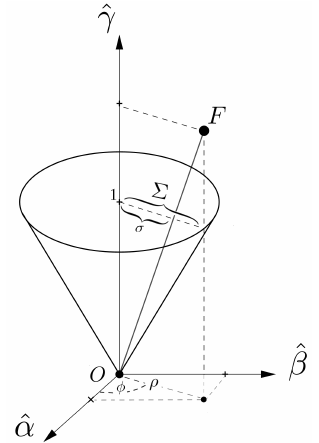
Figure 4. The color cone C for an ideal observer, no glare, nor visibility threshold is considered in this